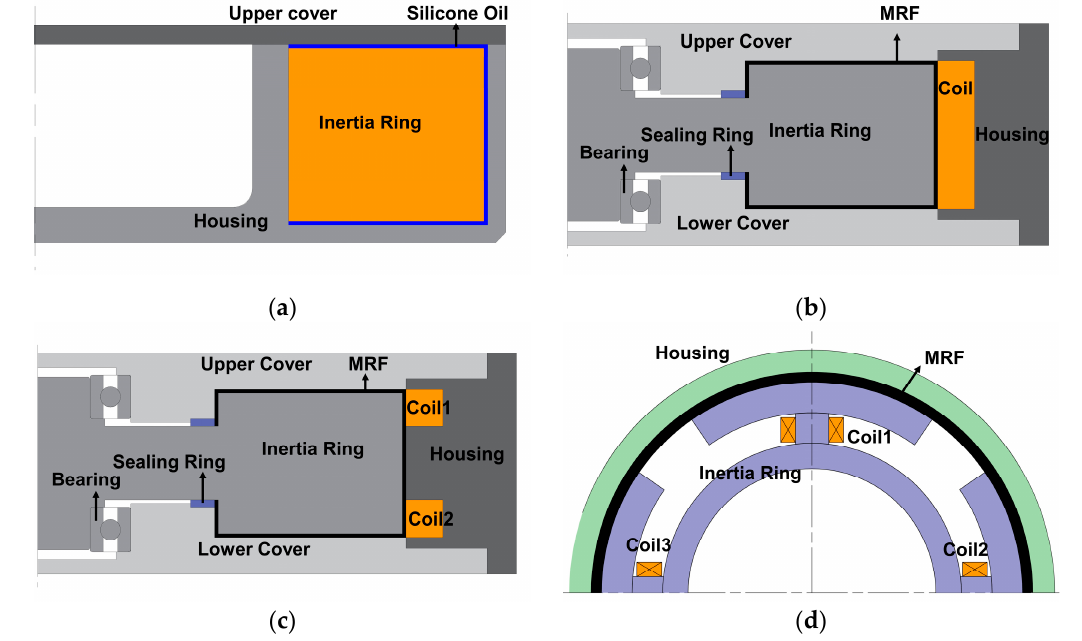
Figure 3. The structure of torsional vibration absorber: ( a ) the structure of the traditional silicone oil torsional vibration absorber; ( b ) axial single-coil con fi guration; ( c ) axial multi-coil con fi guration; ( d ) circumferential con fi guration.